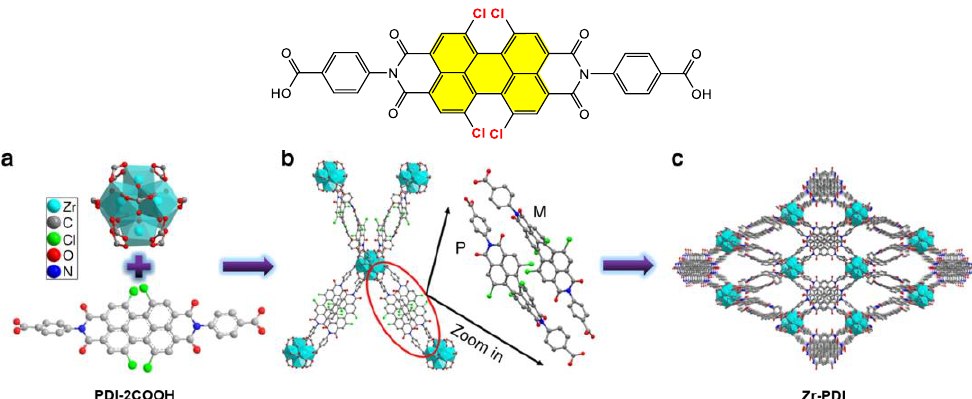
Figure 11. Structure of ligand PDI-2COOH; ( a ) Structures of Zr-cluster and PDI-2COOH, ( b ) con- nection mode of Zr-cluster, ( c ) a-Axis crystal structure of Zr-PDI. Reprinted with permission from Ref. [115]. Copyright 2019 Nature Publishing Group.